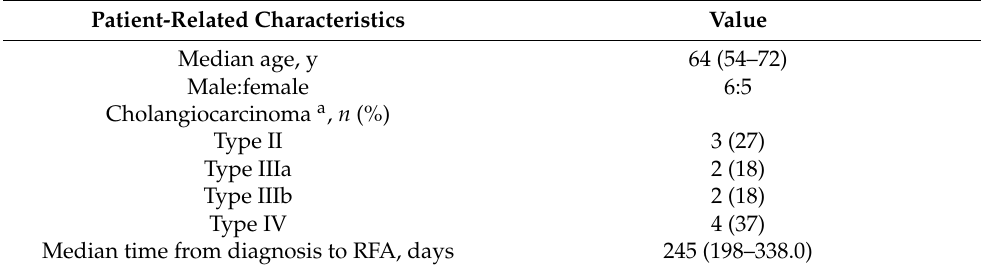
Table 1. Baseline characteristics of the included patients.